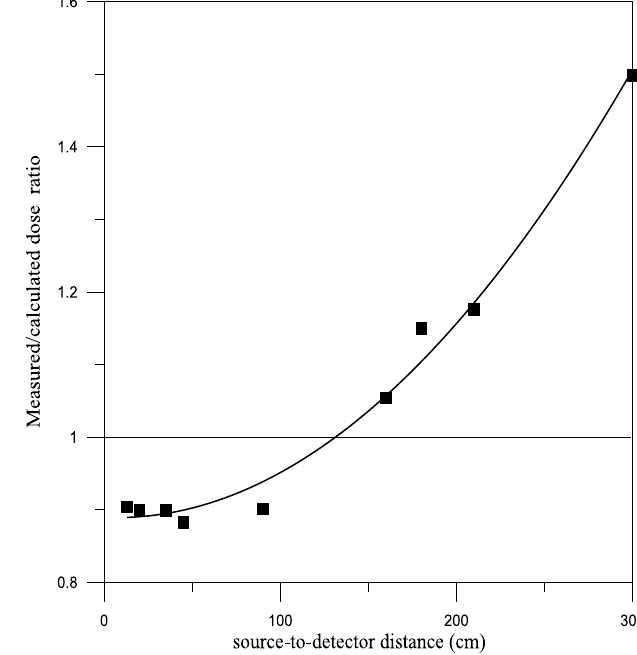
Fig. 4. Measured-to-calculated dose ratio with different source- to-detector distances.